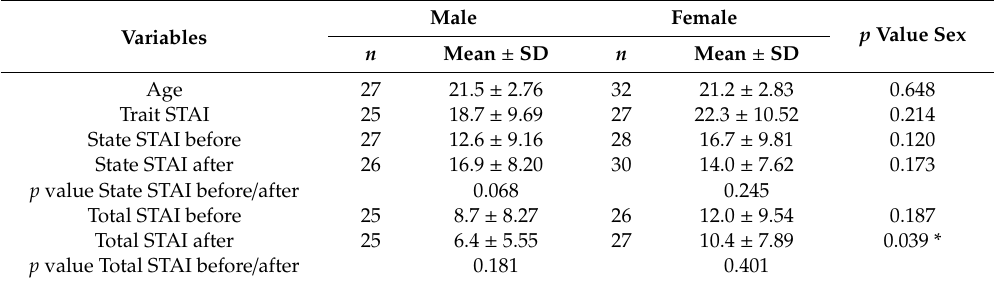
* Statistically significant di ff erences. SD, Standard Deviation.